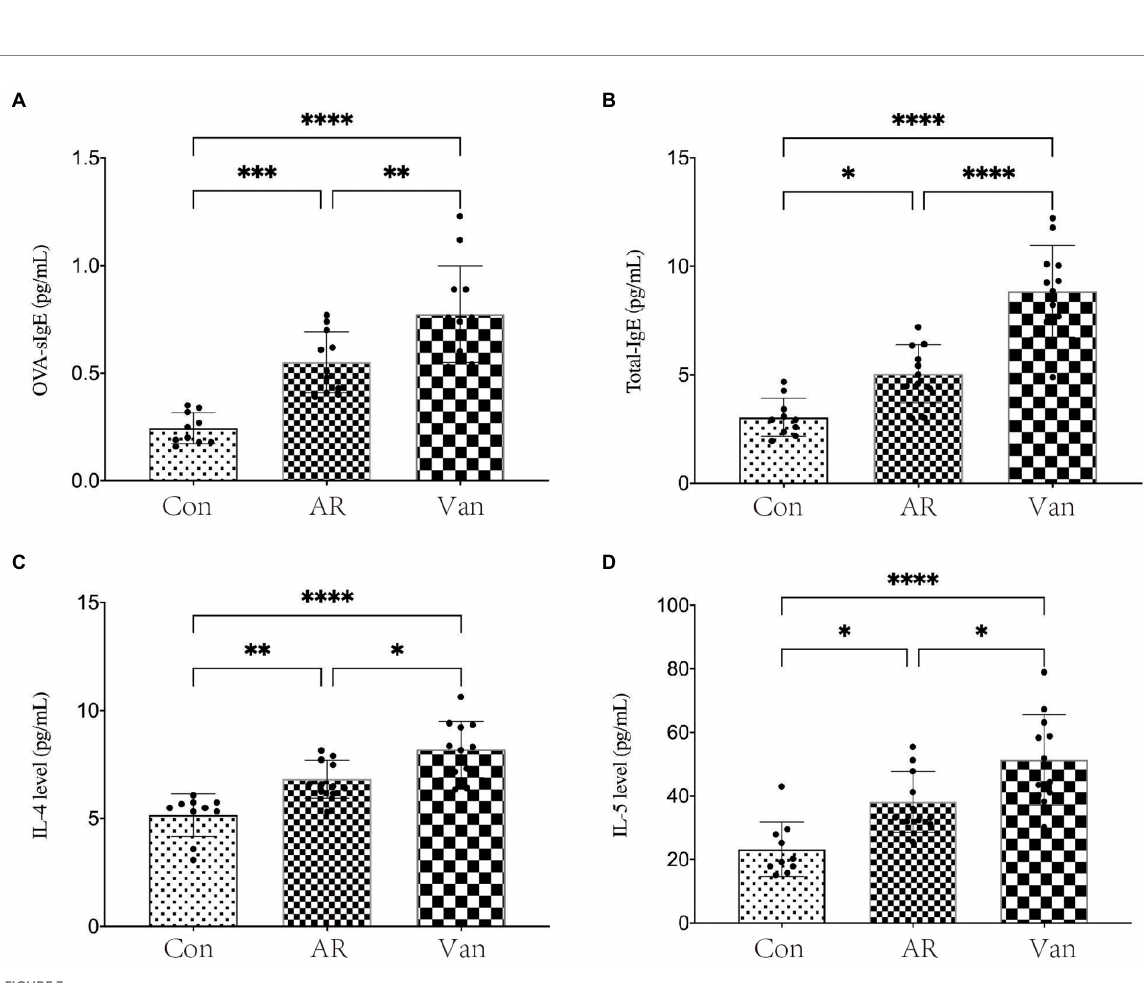
FIGURE 3 Vancomycin elevated serum cytokine and IgE levels in the OVA-induced AR model. (A) ELISA detection of OVA-sIgE in serum. (B) ELISA detection of total IgE in serum. (C) ELISA detection of IL-4 in serum. (D) ELISA detection of IL-5 in serum. ∗ p < 0.05, ∗∗ p < 0.01, ∗∗∗ p < 0.001, ∗∗∗∗ p < 0.0001.